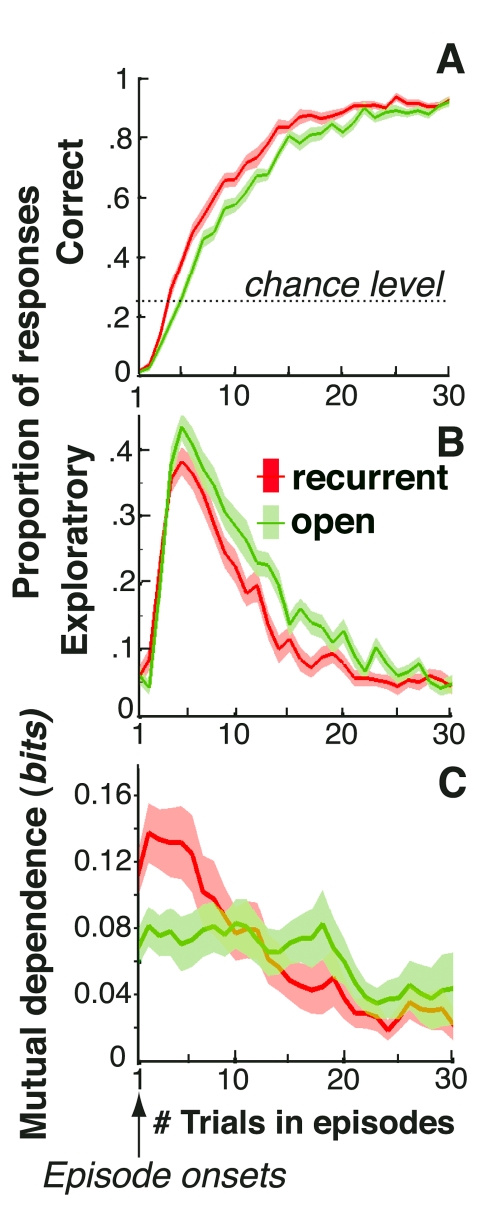
Human decisions with no contextual cues.Participants' performances in recurrent (red) and open (green) episodes plotted against the number of trials following episode onsets. Shaded areas are S.E.M. across participants. (A) Correct response rates. (B) Exploratory response rates. (C) Mutual dependence (i.e., mutual information) of two successive correct decisions averaged over five-trial sliding bins (see Text S1).